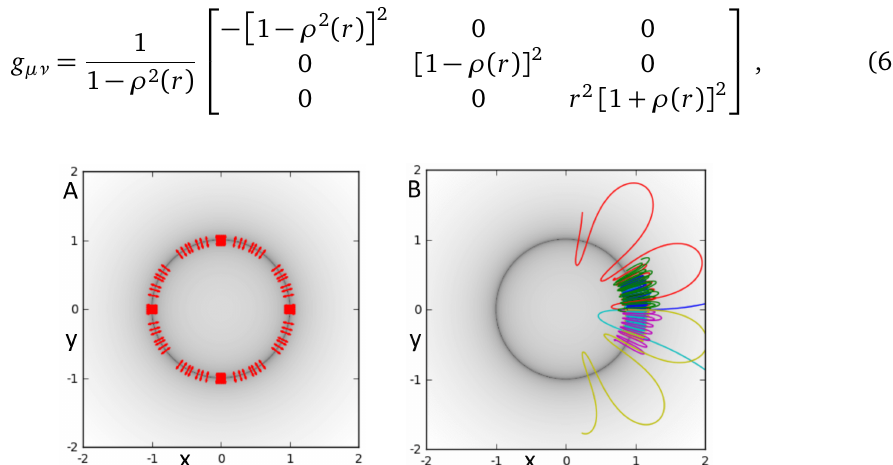
Figure 14: Null geodesic trajectories for the rotationally symmetric nematic model defined by Eq. (68), with ρ ( r ) = r . A: The singular manifold r ∗ = 1, labeled with collimation arrows. B: Geodesic dynamics. Note that many geodesics are in bound states along the singular wall, and all wall crossings occur at the correct collimation angle. The condition for bound-state null geodesics is e < 1, where the eccentricity e is defined in Eq.